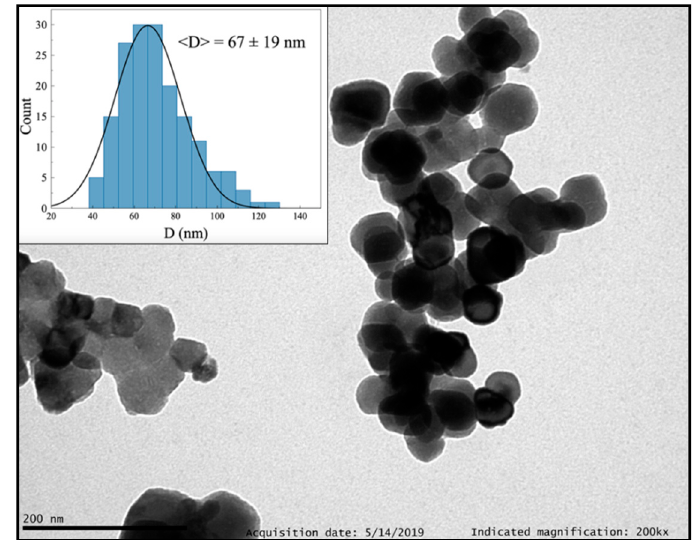
Figure 5. TEM image of Y 2 O 3 : Pr 3+ NCs prepared by molten salt method after 10 washing cycles.